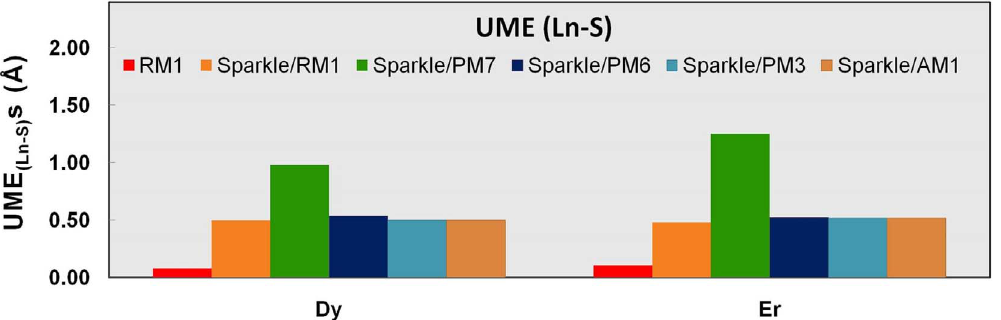
Figure 5. UME (Ln-S) obtained using the RM1 model for the lanthanides and all five versions of the Sparkle Model: Sparkle/RM1, Sparkle/PM7, Sparkle/PM6, Sparkle/PM3 and Sparkle/AM1 for all complexes of the universe set for each of the lanthanide trications: Dy(III), Ho(III) and Er(III). The UMEs are calculated as the absolute value of the difference between the experimental and calculated Ln- S interatomic distances, summed up for all complexes, for each of the lanthanides. There are no Ho-S distances in the universe of Ho(III) complexes considered.